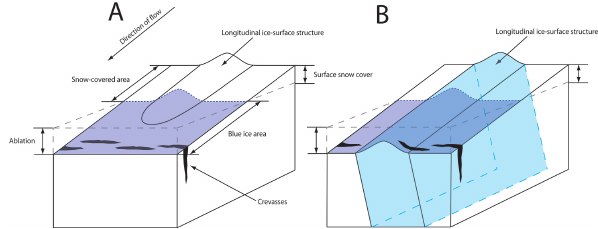
Figure 8. Schematic diagram to illustrate the expected down-ice changes in (a) a two-dimensional longitudinal ice-surface structure and (b) a three-dimensional longitudinal ice-surface structure. The major difference is that, because it is a surface-only feature, a two- dimensional longitudinal ice-surface structure cannot survive sur- face ablation and thus disappears down-ice as it is advected into an area of glacier surface ablation such as a blue-ice area. A three- dimensional longitudinal ice-surface structure, however, can survive surface ablation and therefore persists